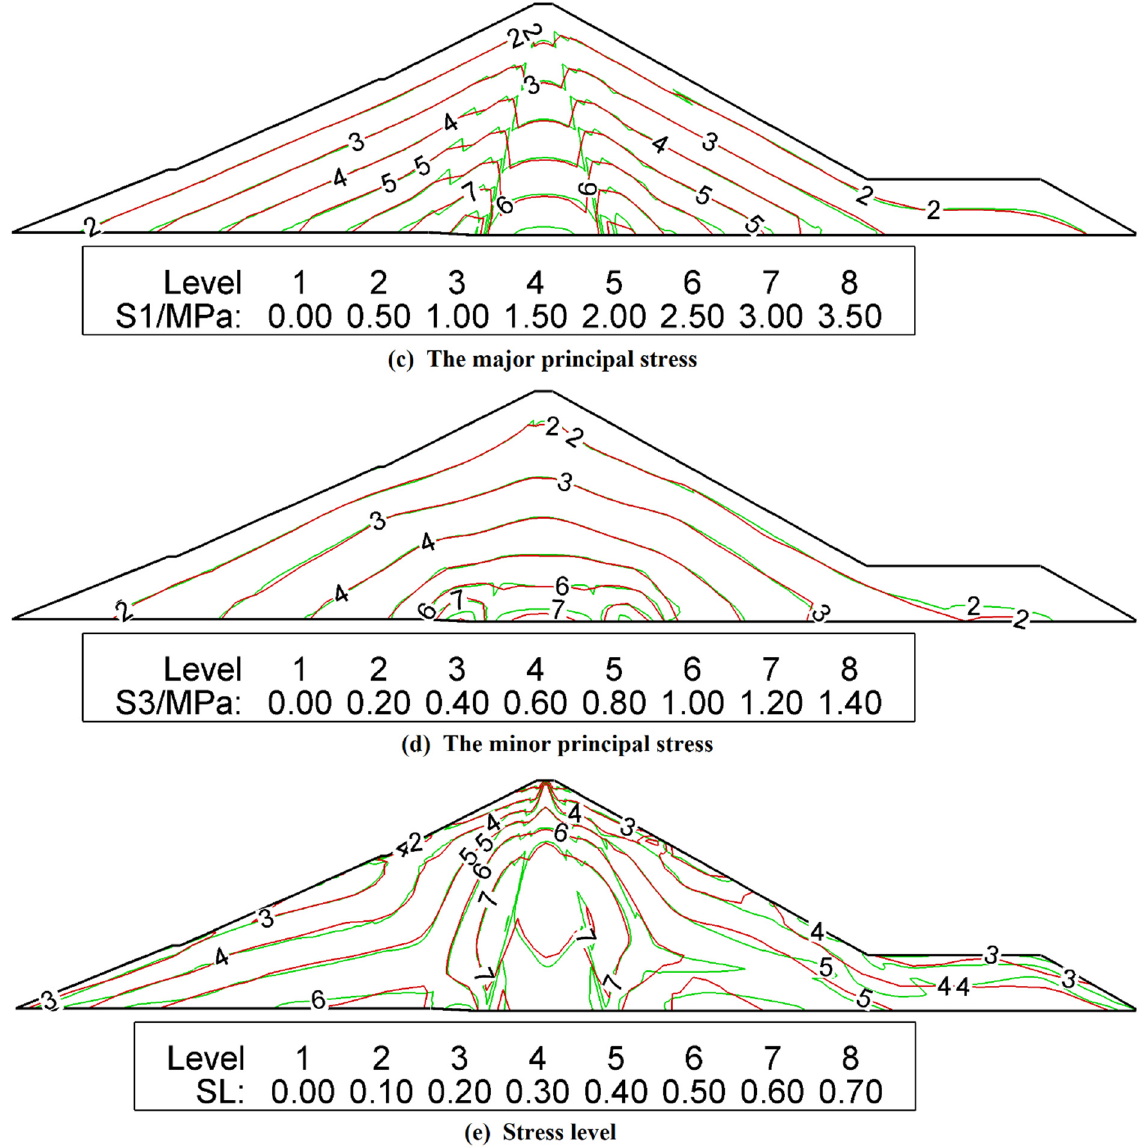
Figure 11. The calculated results of the 240.0 m section when the water level reaches 844.0 m of elevation.